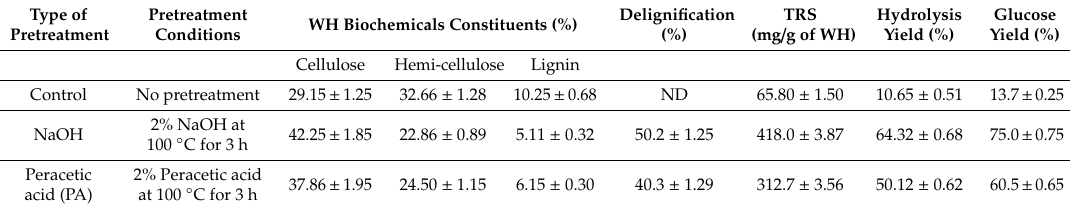
Table 2. E ff ects of alkaline and peracetic acid pretreatment on WH biochemical constituents, delignification, and hydrolysis yield and glucose yield after enzymatic